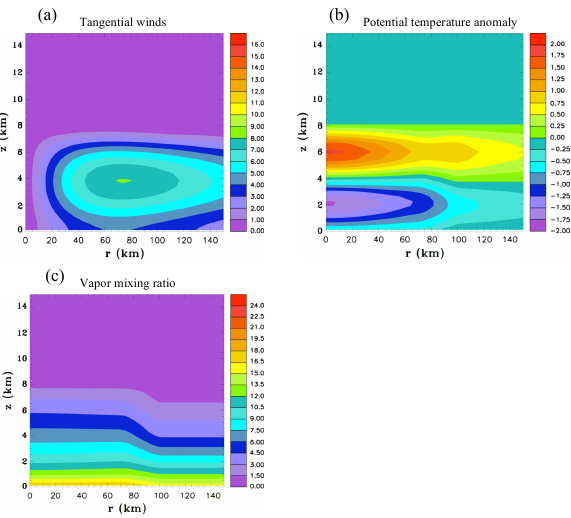
Figure 1. Initial conditions for a small weak vortex with a moisture anomaly. (a) Tangential winds. The contour interval is 1 m s -1 . (b) Potential temperature anomaly. The contour interval is 0.25 K. (c) Water vapor mixing ratio. The contour interval is 1.5 g kg -1 .